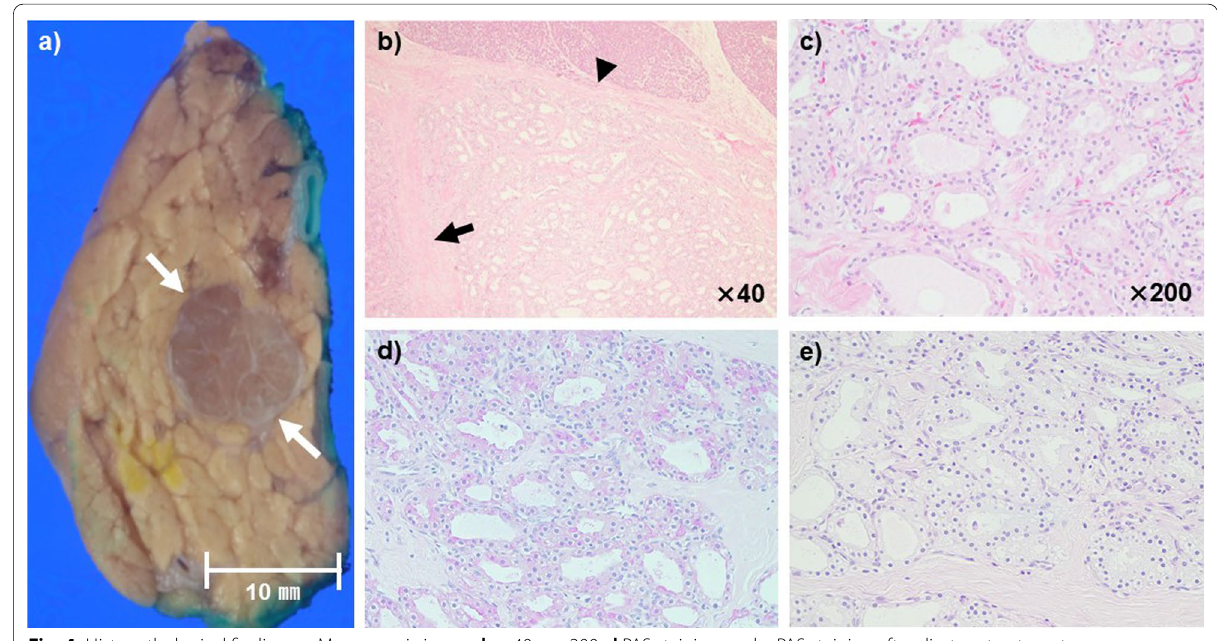
Fig. 4 Histopathological findings. a Macroscopic image, b 40, c 200, d PAS staining, and e PAS staining after diastase treatment. × × Macroscopically, the tumor was a well-defined, round, and solid mass without cystic components measuring 15 mm in size (white arrows in a ). Microscopically, it appeared as a well-defined lesion with thick fibrous interstitium (arrow in b ), covered with a membrane (arrowhead in b ), and composed of epithelial cells having clear vesicles forming microcysts ( c ). The epithelial cells were positive for PAS staining ( d ) before the diastase treatment and negative for PAS staining after the treatment ( e